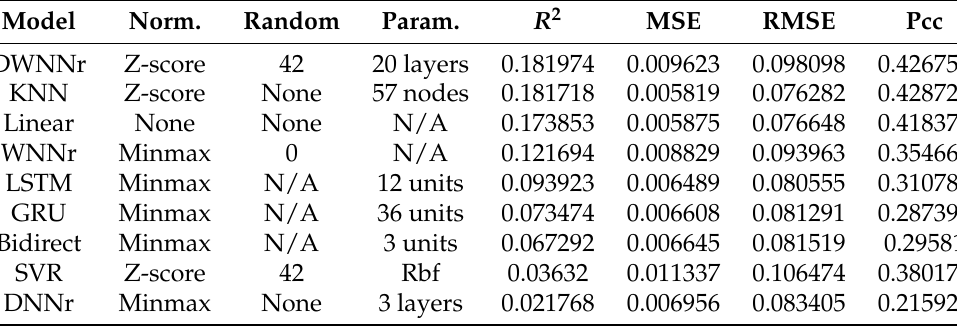
Table 10. Overall Performance in ROC + BUF + SYR + ALB dataset.